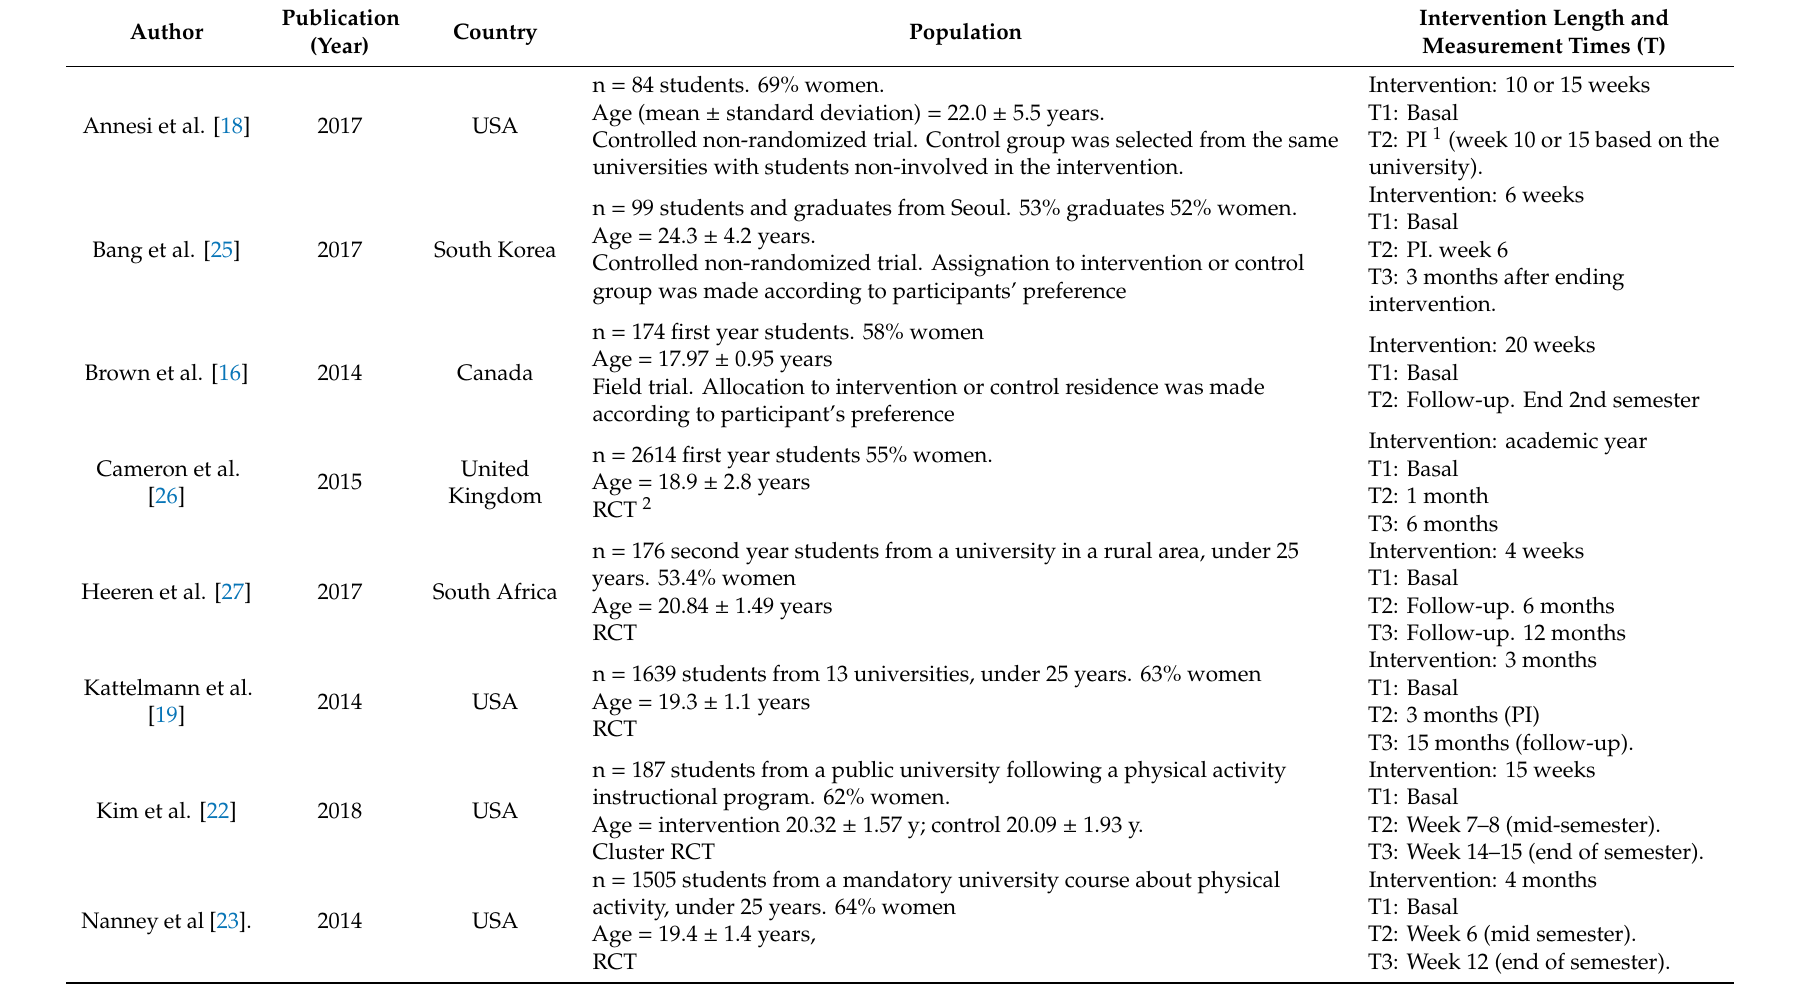
Table 1. Descriptive characteristics of the included